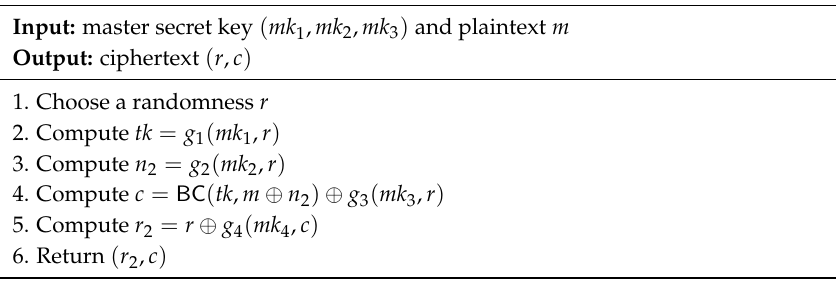
Algorithm 5 Higher order SCA-resistant re-keying encryption scheme: enc HO − RK